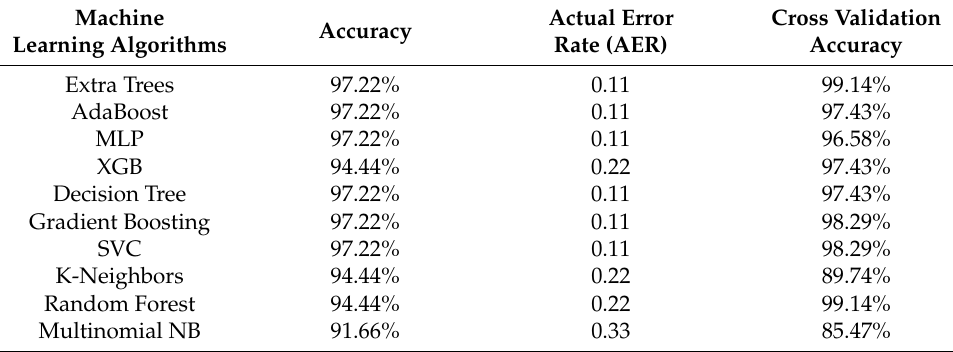
Table 1. Evaluation metrics to determine the performance of the machine learning models.